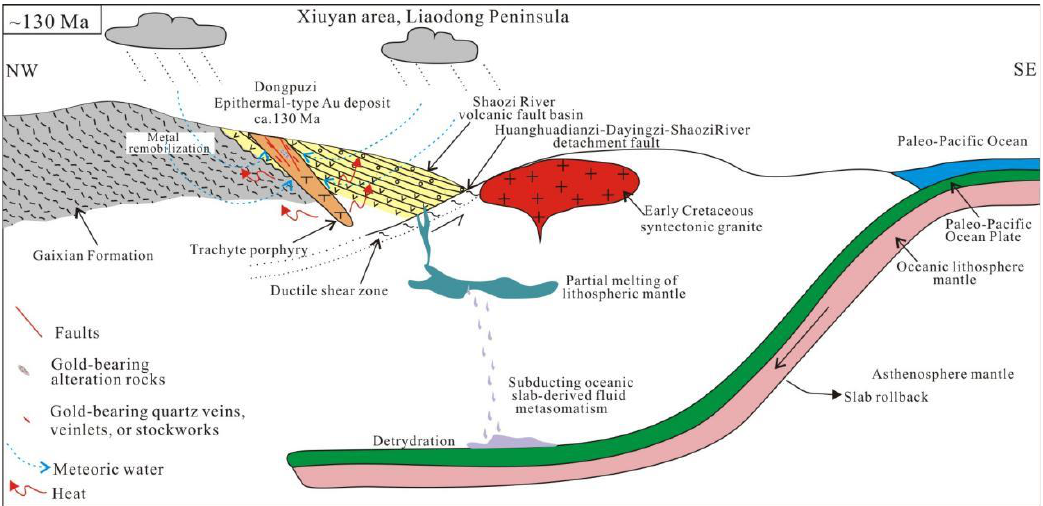
Figure 9. Schematic model explaining the formation of the Dongpuzi gold deposit (the geodynamic setting of the Early Cretaceous in the eastern NCC is after [11,13,40–43]; the diagenesis of intermediate–basic rocks of the Xiaoling Formation is after [28]; the age of ~130 Ma is taken from unpublished U – Pb data of the trachyte porphyry).